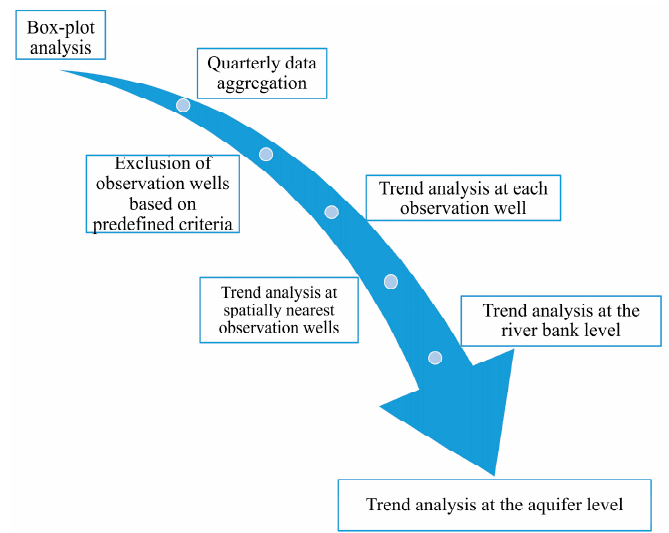
Figure 3. Trend analysis estimation flow chart.